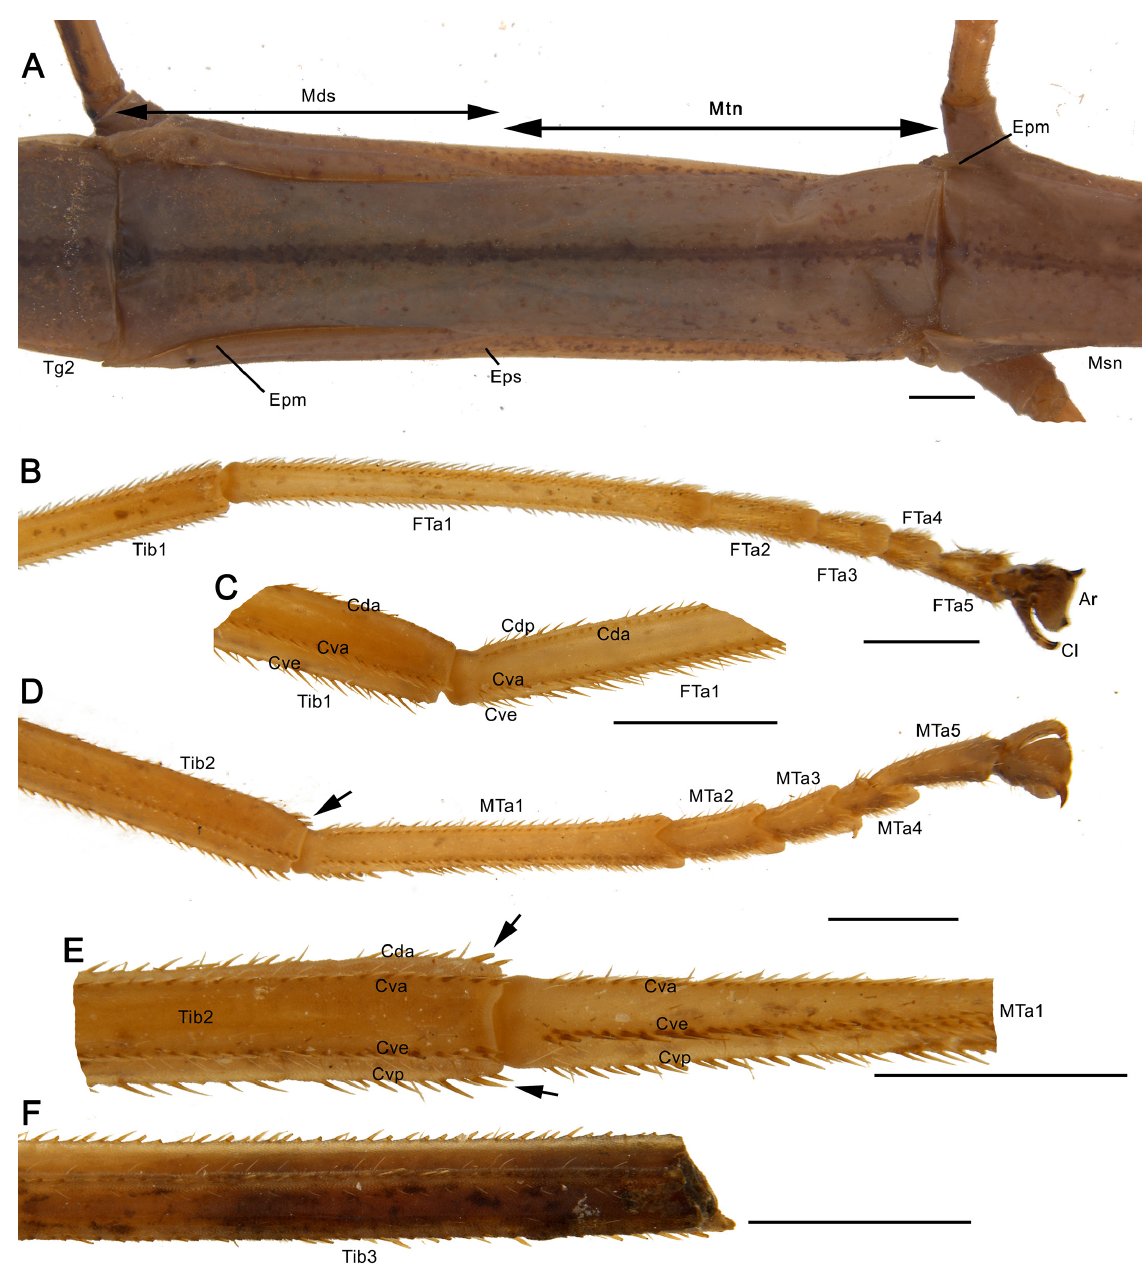
Fig. 27. Arumatia aramatia Ghirotto gen. et sp. nov., holotype, ♀ (MZUSP 1352), thorax and leg morphology. A . Metathorax and median segment in dorsal view, arrows indicate the length of each segment. B . Left fore tarsus, ventral view. C . Detail of right fore tibia and tarsus (mirrored), prolateral view. D . Right mid tarsus (mirrored), prolateral view, arrows showing stronger apical spines. E . Detail of left mid tibia and tarsus, ventral view, arrow showing stronger apical spines. F . Detail of broken apex of left tibia, dorsal view. Abbreviations: Ar = arolium; Cda = dorsal anterior carina; Cdp = dorsal posterior carina; Cl = claw; Cva = ventral anterior carina; Cve = ventral carina; Cvp; ventral posterior carina; Epm = epimeron; Eps = episternum; FTa = fore tarsomere; Mds = median segment; Msn = mesonotum; MTa = mid tarsomere; Mtn = metanotum; Tg = tergum; Tib = tibia. Scale bars: 1